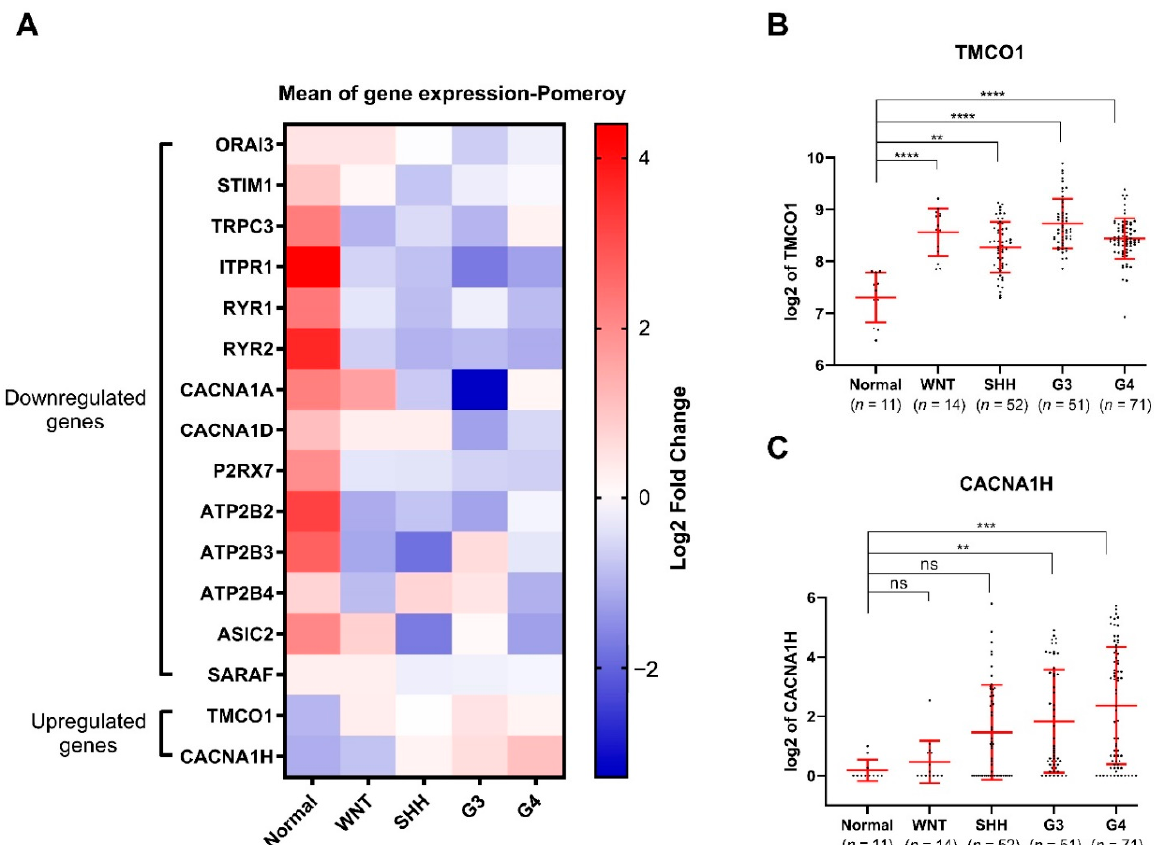
Figure 2. Expression of 2 upregulated and 14 downregulated Ca 2+ transporter genes in MB subgroups compared to normal cerebellum present in the the Pomeroy dataset [17]: ( A ) Heatmap presenting the mean expression of the 16 identified Ca 2+ transporter genes in MB subgroups compared to normal cerebellum; ( B ) TMCO1 and ( C ) CACNA1H mRNA expression in the Pomeroy dataset [17] via the R2 Genomics Analysis and Visualization Platform. The number of individuals in each group is listed below. ns: not significant p > 0.05, ** p < 0.01, *** p < 0.001, **** p- value < 0.0001, non-parametric test, with Kruskal Wallis test multiple comparisons, mean with SD.